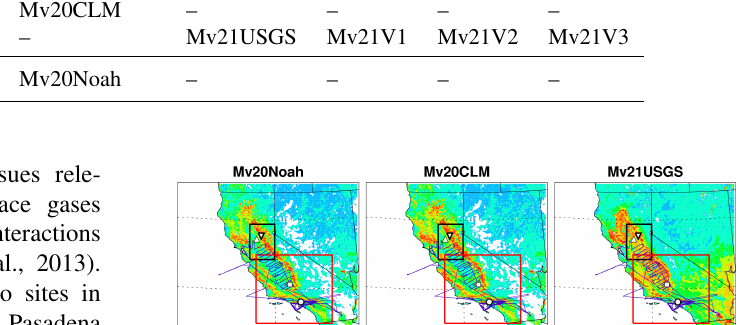
Table 2. Experiments of WRF-Chem. Surface BVOC Plant function type data set scheme scheme